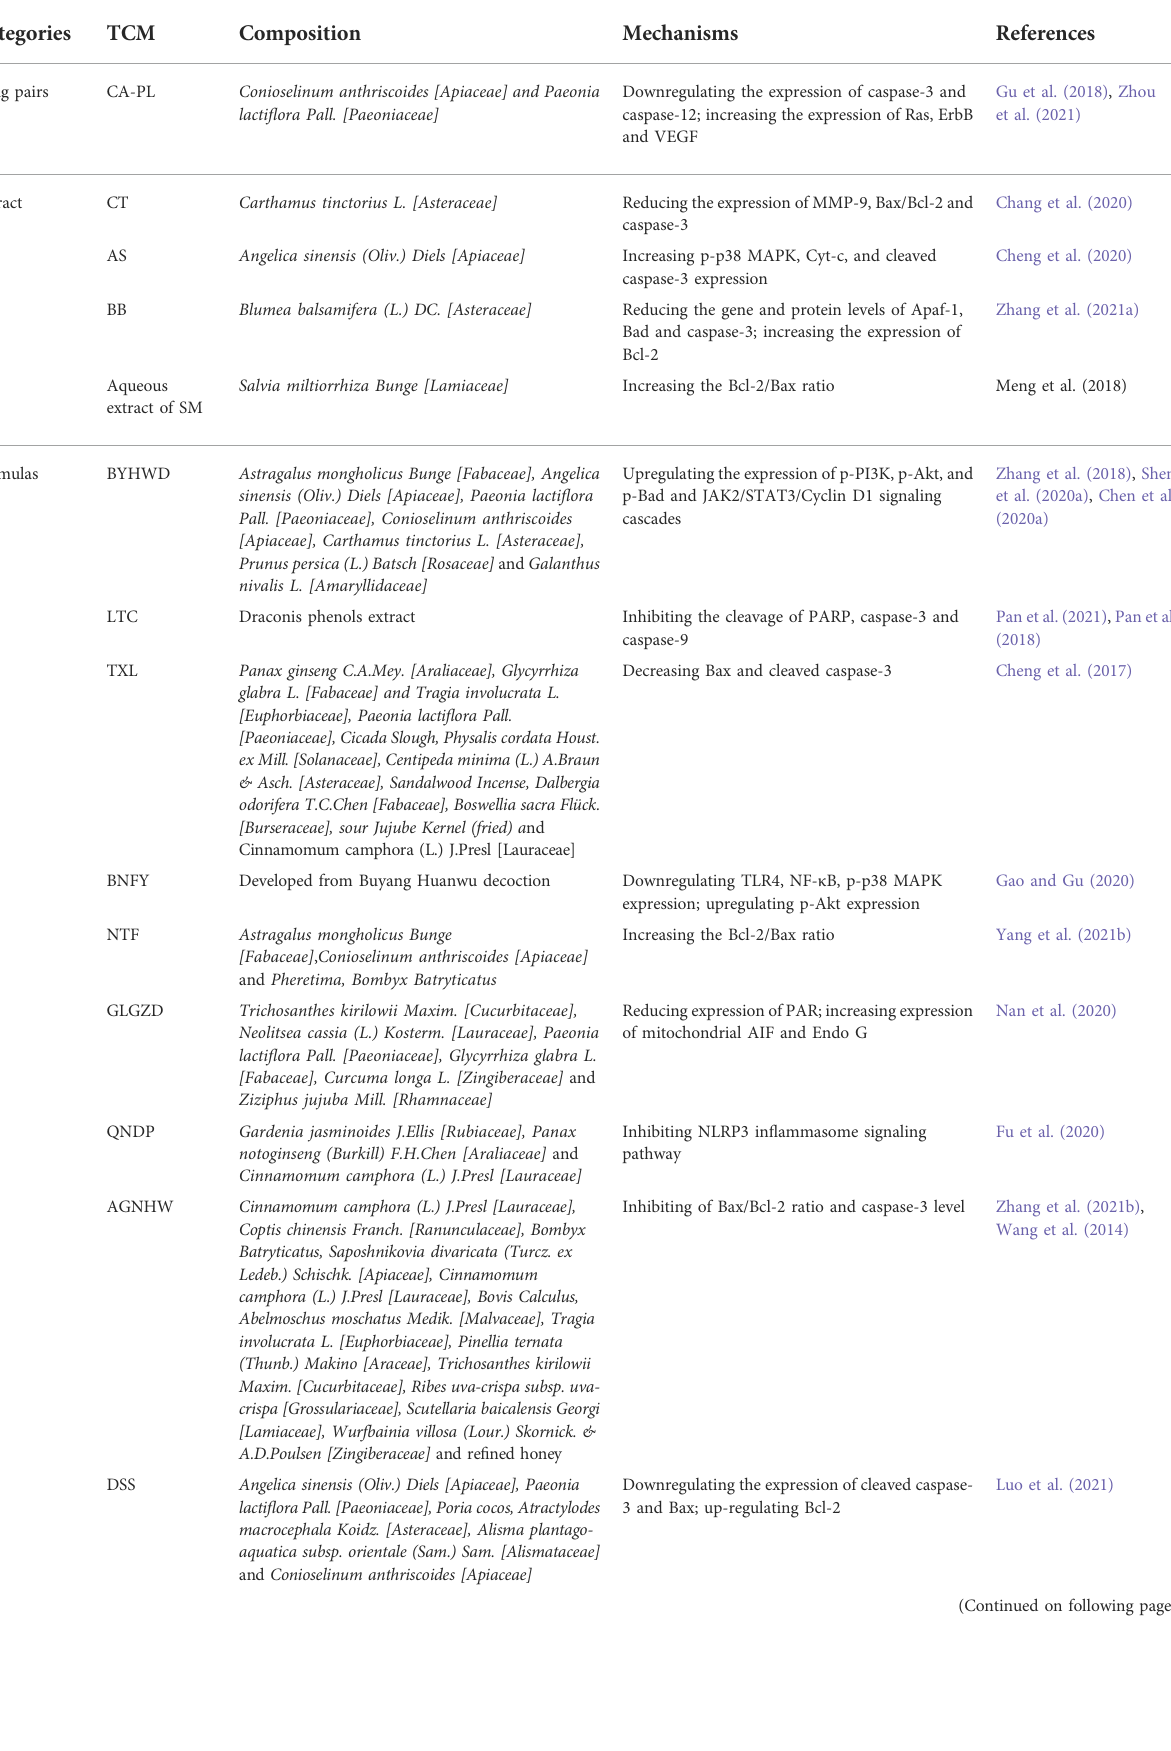
TABLE 2 The involved mechanisms of representative TCM prescriptions in the treatment of cerebral ischemia.